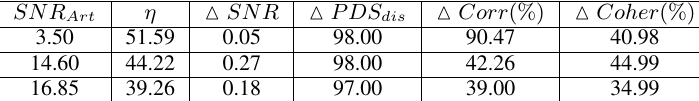
TABLE I R ESULTS FOR A RTIFACT R EMOVAL B ASED ON D IFFERENT A RTIFACT SNR ( SNR Art )